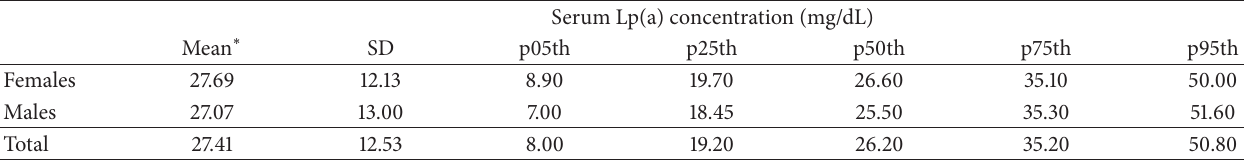
Table 3: Mean values and percentile distribution of serum Lp(a) concentrations in the general population and by gender. The Maracaibo City Metabolic Syndrome Prevalence Study,